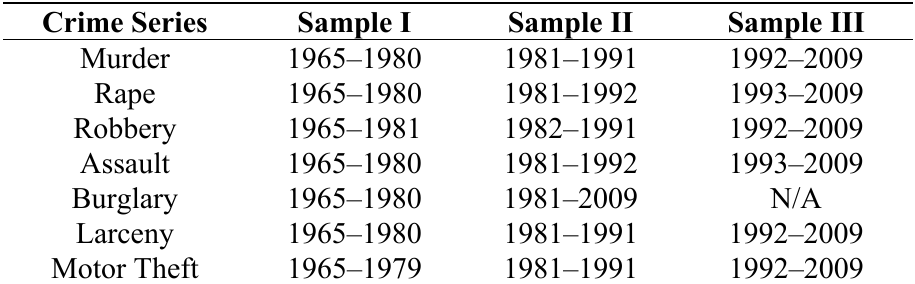
Table1. Identifying Regimes in the Evolution of